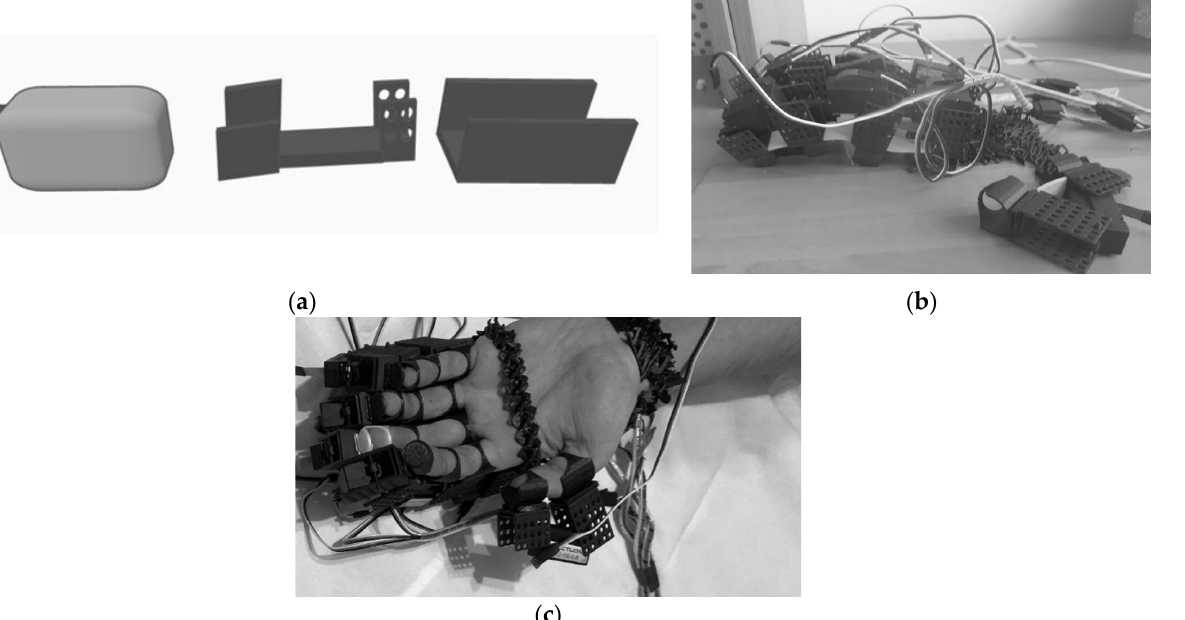
Figure 1. Selected 3D-printed exoskeletons mentioned in the article: ( a ) elbow exoskeleton, ( b ) hand exoskeleton, and ( c ) hand in hand exoskeleton.